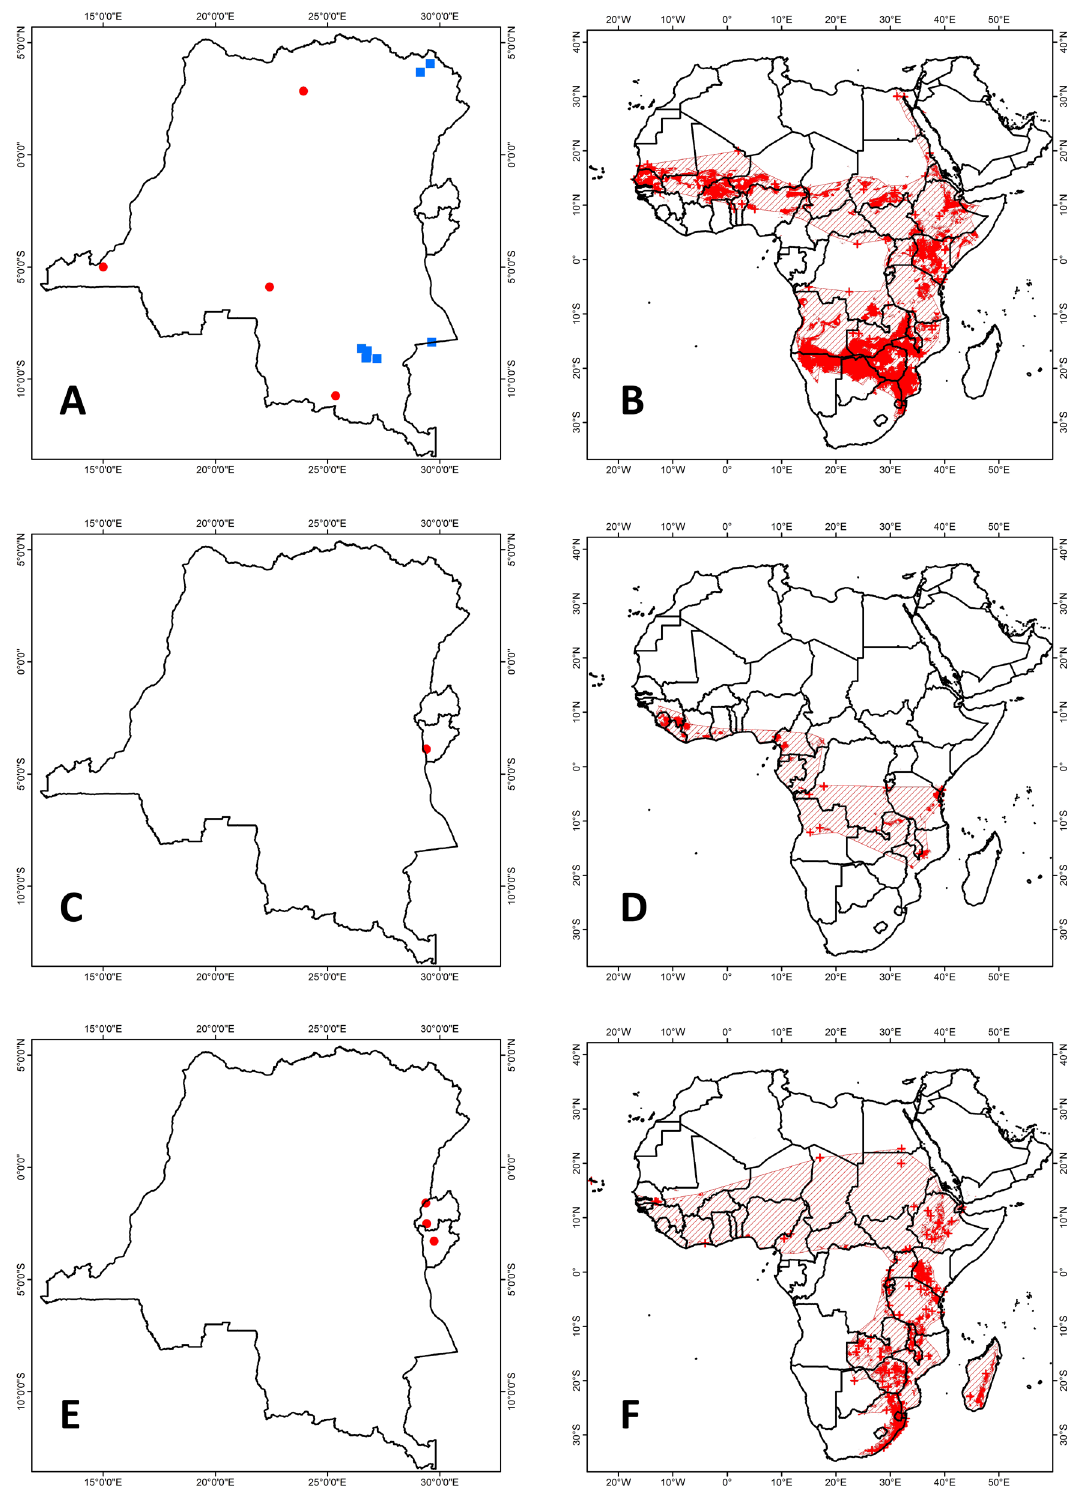
Fig. 46. Distribution maps. A–B . Nycticeinops schlieffenii (Peters, 1860). C–D . Pipistrellus grandidieri (Dobson, 1876). E–F . Pipistrellus hesperidus (Temminck, 1840). A, C, E. Distribution in the CRB area. B, D, F. Pan-African